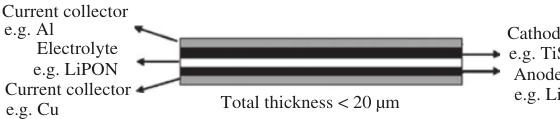
Figure 4: Schematic diagram of a stacked thin-film lithium-ion cell. Reprinted from [28].